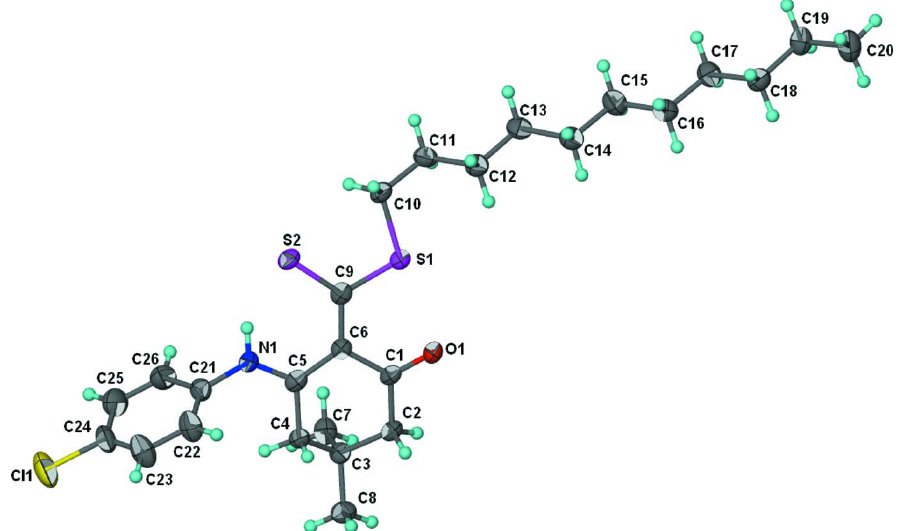
Anisotropic displacement ellipsoid plot (Barbour, 2001) plot of C atoms are drawn as spheres of arbitrary